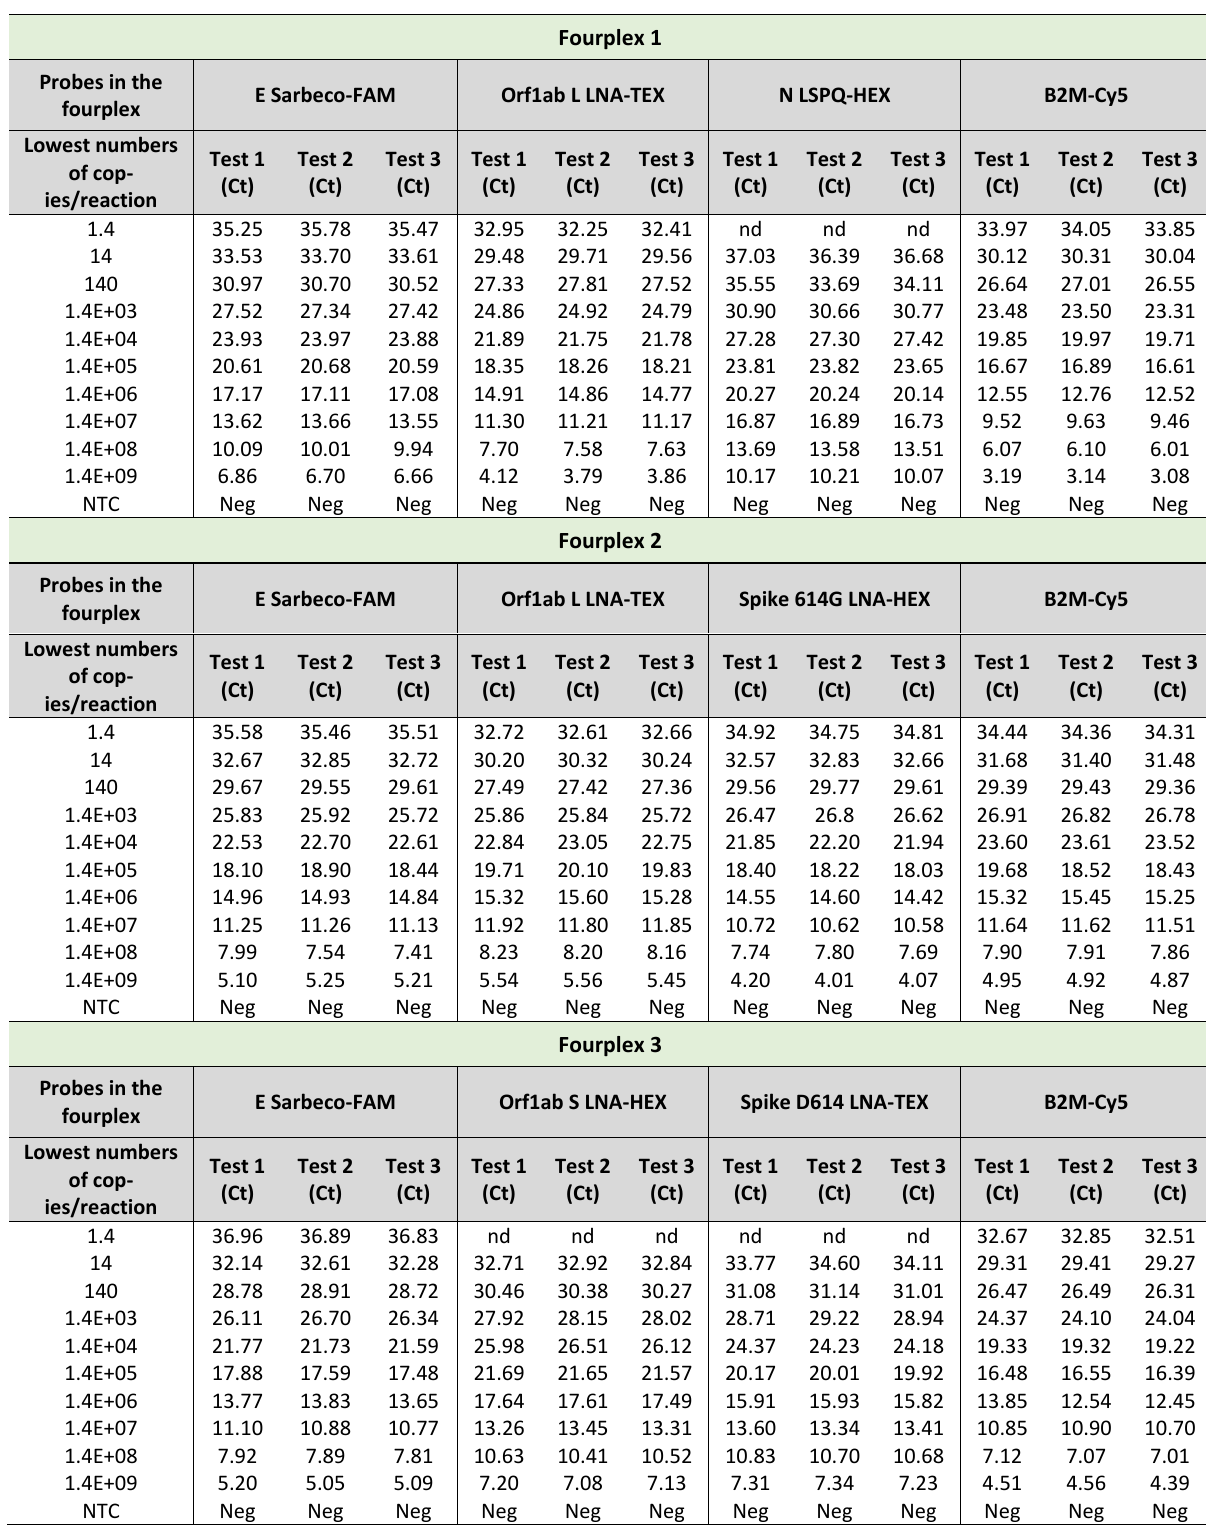
Table 3. Sensitivities of SARS-CoV-2-specific primers and probes in fourplex rRT-PCR